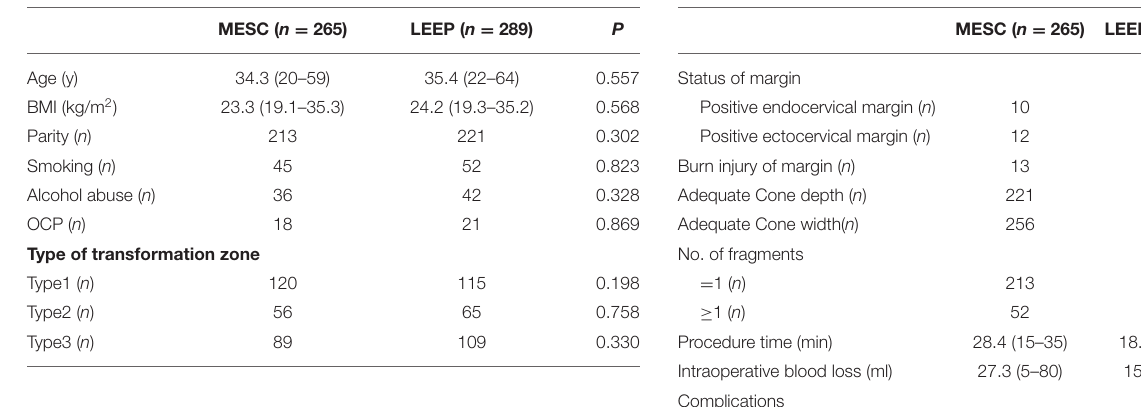
TABLE 1 | Characteristics of patients with HSIL of the cervix. TABLE 2 | Comparison of the outcomes of HISL treated through LEEP or MESC.